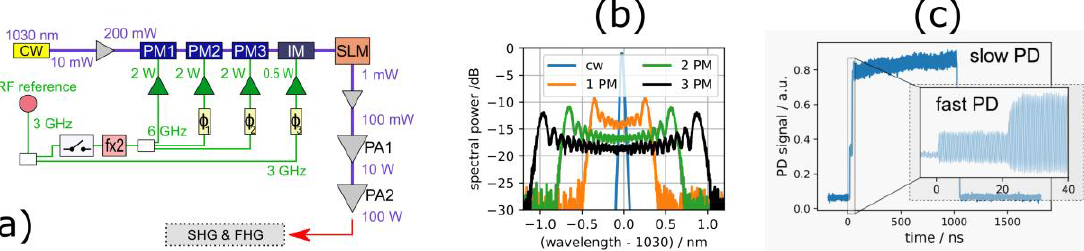
Fig. 1 (a) Schematic of the Photocathode laser system. (b) Optical spectra of the cw laser, and after each of the phase modulator stages. (c) Photo diode trace of a short burst generated by the system at 515 nm. The inset shows a zoom to the rising edge of the burst, resolving the pulse train of 3 GHz repetition